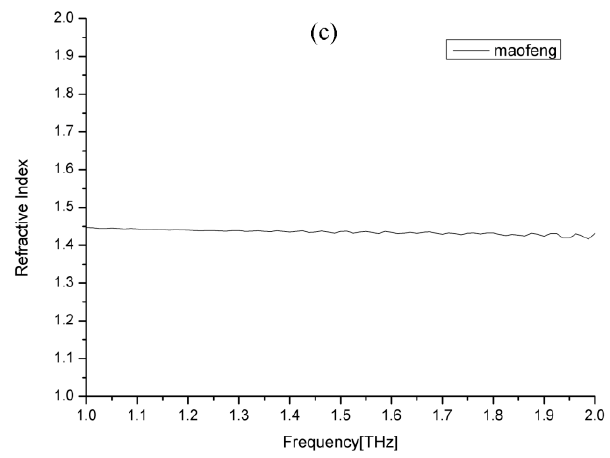
Figure 3. ( a ) The time domain signals of reference (pure PE pellet) and a Maofeng sample; ( b ) the absorption of maofeng sample at 0.2–1 THz; and ( c ) the refractive index of Maofeng sample at 0.2–1.2 THz.